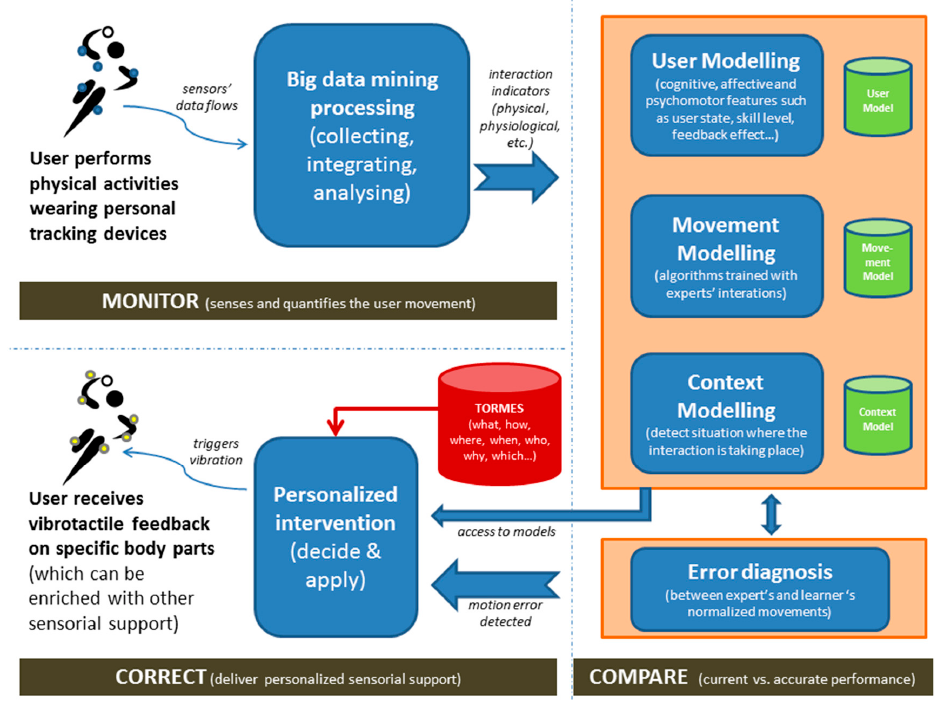
Figure 1. Schema of the three processing steps (monitoring, comparing and correcting) required to deliver vibrotactile personalized feedback for adaptive learning of motor skills.